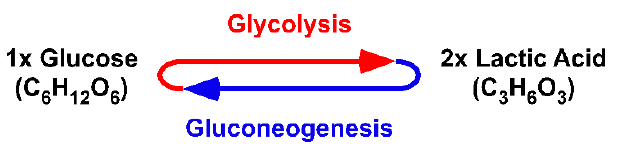
Figure 1. Glucose metabolism as an equilibrium. One molecule of glucose is degraded to two molecules of lactic acid by the process of glycolysis. The reverse synthetic reaction, gluconeogenesis is the conversion of lactic acid to glucose. Meyerhof proposed that the breakdown and synthesis were in equilibrium [28].